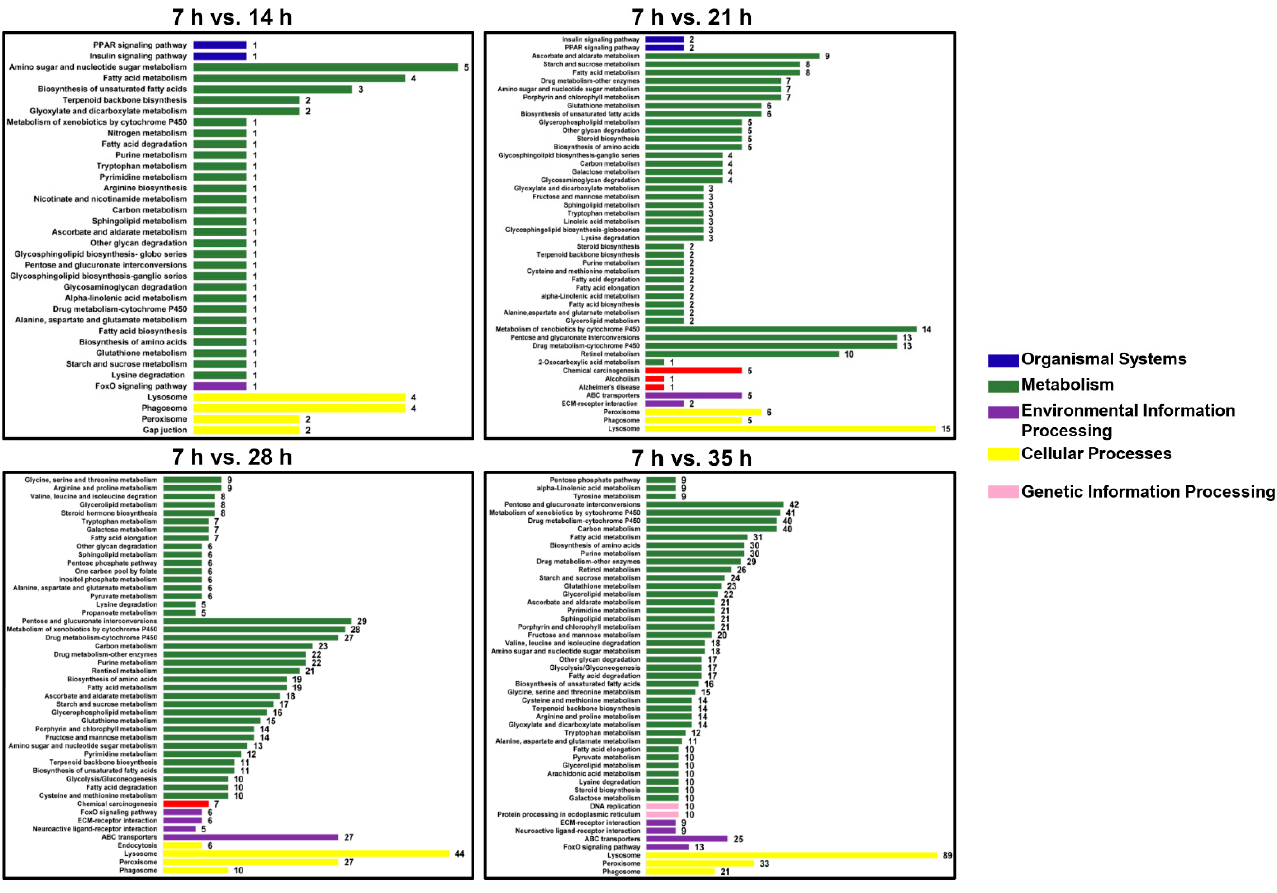
Figure 2. KEGG pathway classification for differential expression genes (DEGs) in different developmental time points (14 h vs. 7 h, 21 h vs. 7 h, 28 h vs. 7 h and 35 h vs. 7 h) of deutonymph in T. urticae .